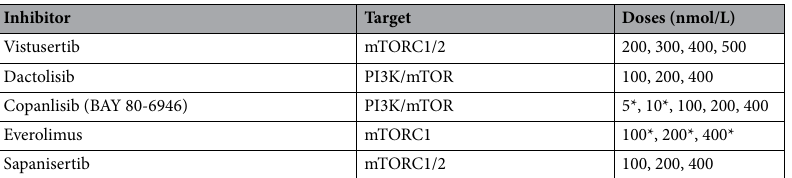
Table 2. PI3K pathway inhibitors and doses of inhibitors used in organoid response characteristics analyses. Multiple PI3K pathway inhibitors were assessed in the organoid response characteristic analyses ranging from 5 to 500 nmol/L. *Doses used only in UMAP